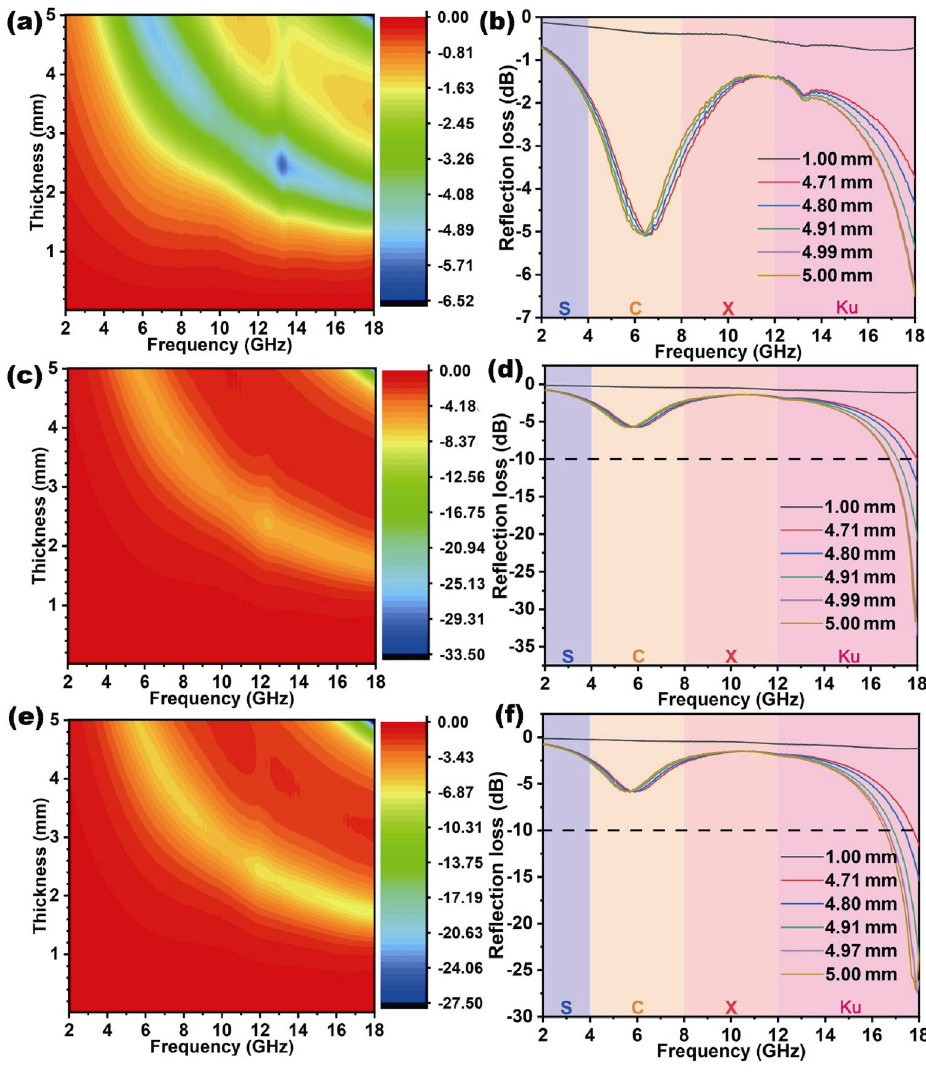
Fig. 8 (a–f) Color maps of the reflection loss: (a, b) ZnO/NiCo 2 O 4 -5; (c, d) ZnO/NiCo 2 O 4 -7; and (e, f) ZnO/NiCo 2 O 4